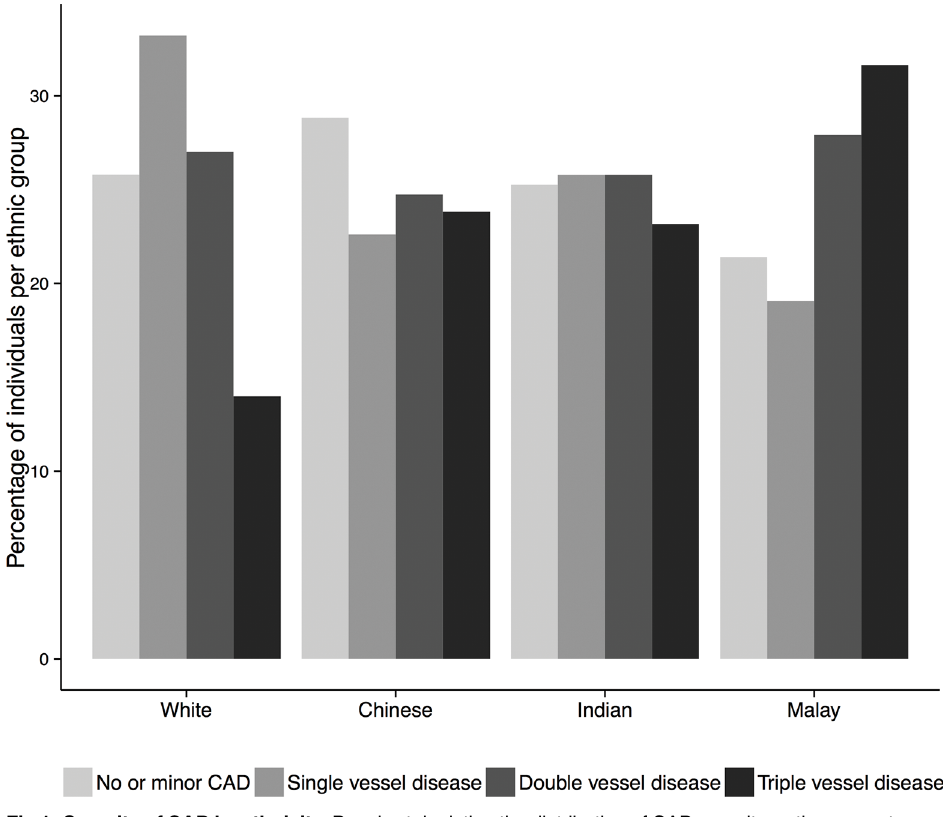
Fig 1. Severity of CAD by ethnicity. Bar chart depicting the distribution of CAD severity as the percentage of the total number of individuals per ethnic group. Triple vessel disease is significantly more common among Chinese, Indians and Malays than among Whites (p <